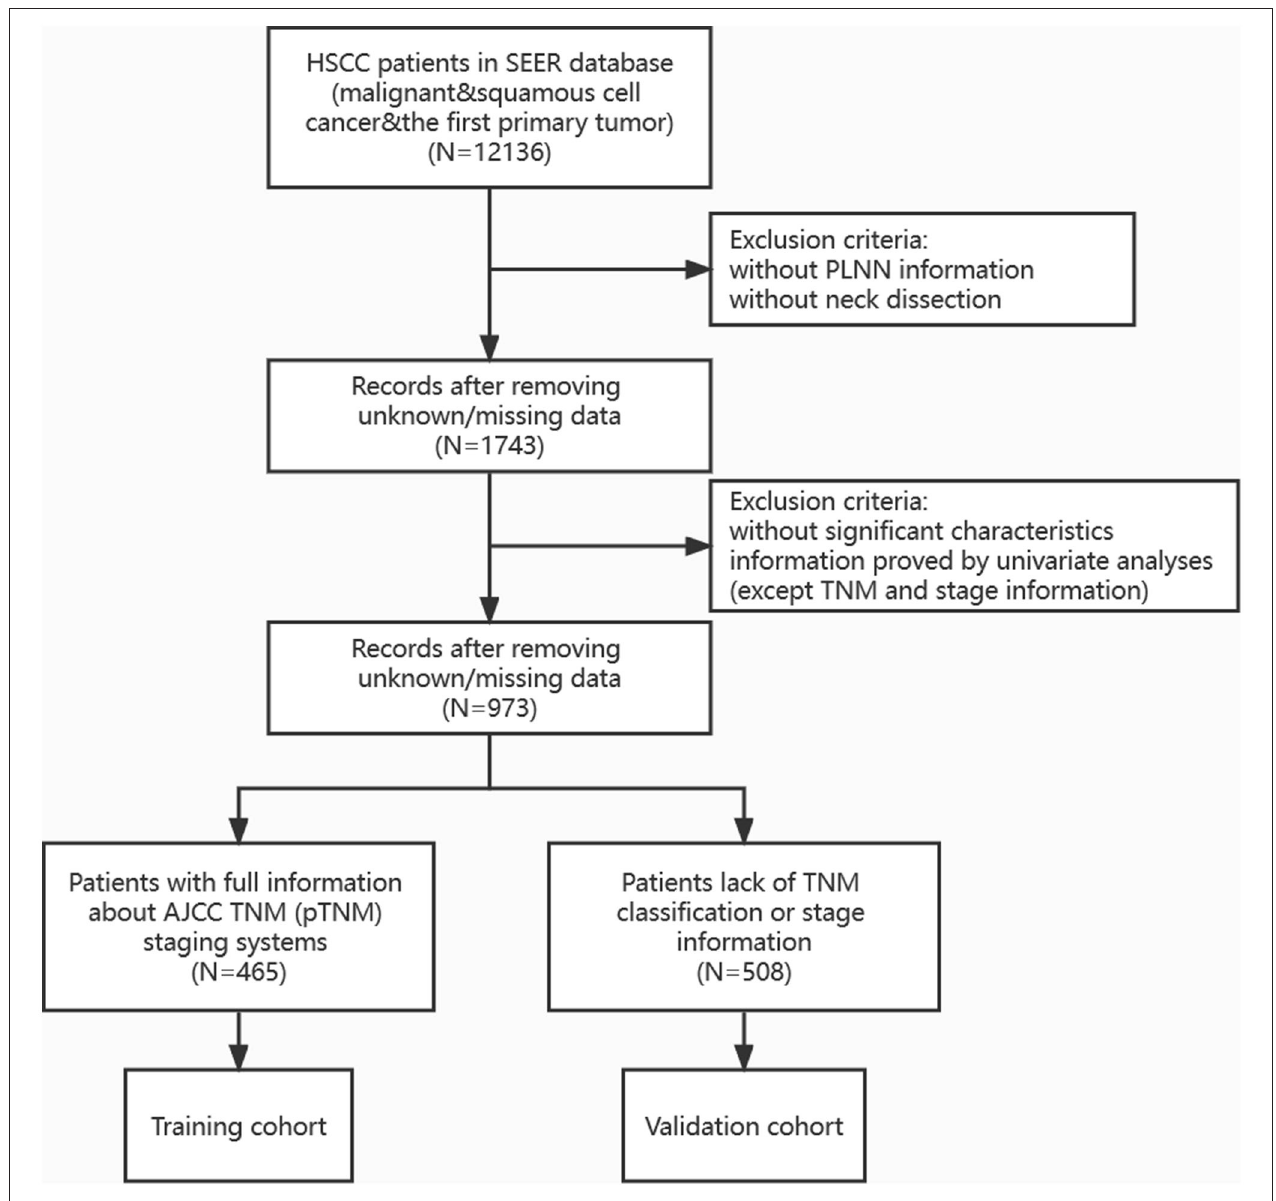
FIGURE 1 | Flow diagram summarizing the process of inclusion and